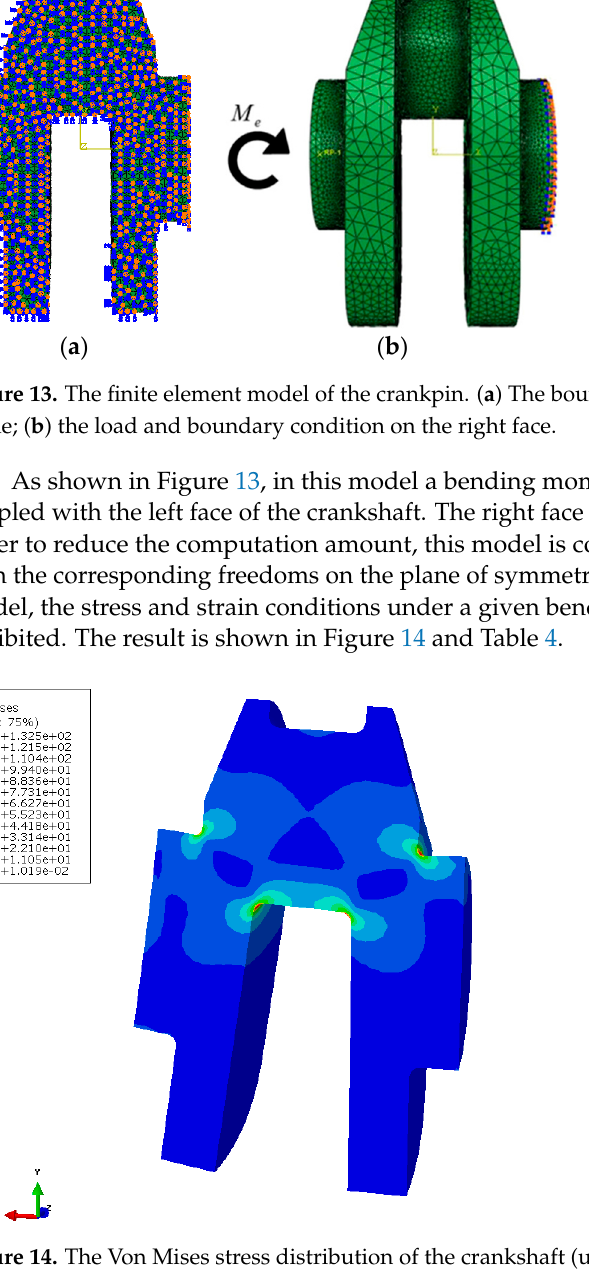
Figure 12. The process of the coordinate transition method.